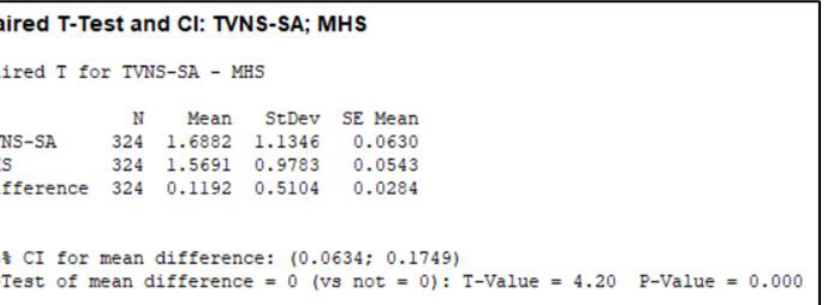
Figure 13. Paired t -test for the MHS and two-stage hybrid variable neighborhood search with sim- ulated annealing (TVNS-SA) performance differences.